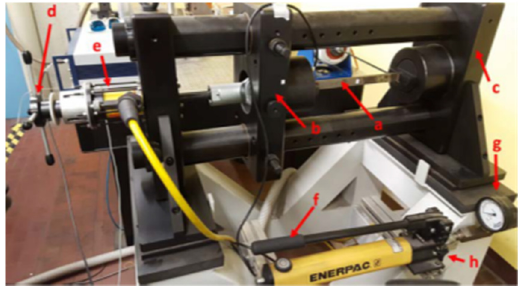
Figure 2. Support and traction system; Blade (a), mobile piece (b), fixed piece (c), handle (d), oil pump (e), hydraulic actuator handle (f), pressure gauge (g), hydraulic actuator (h).